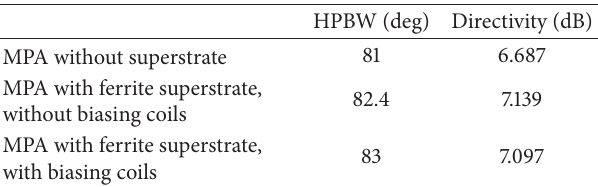
Table 1: Measured HPBW and directivity for designed antenna with